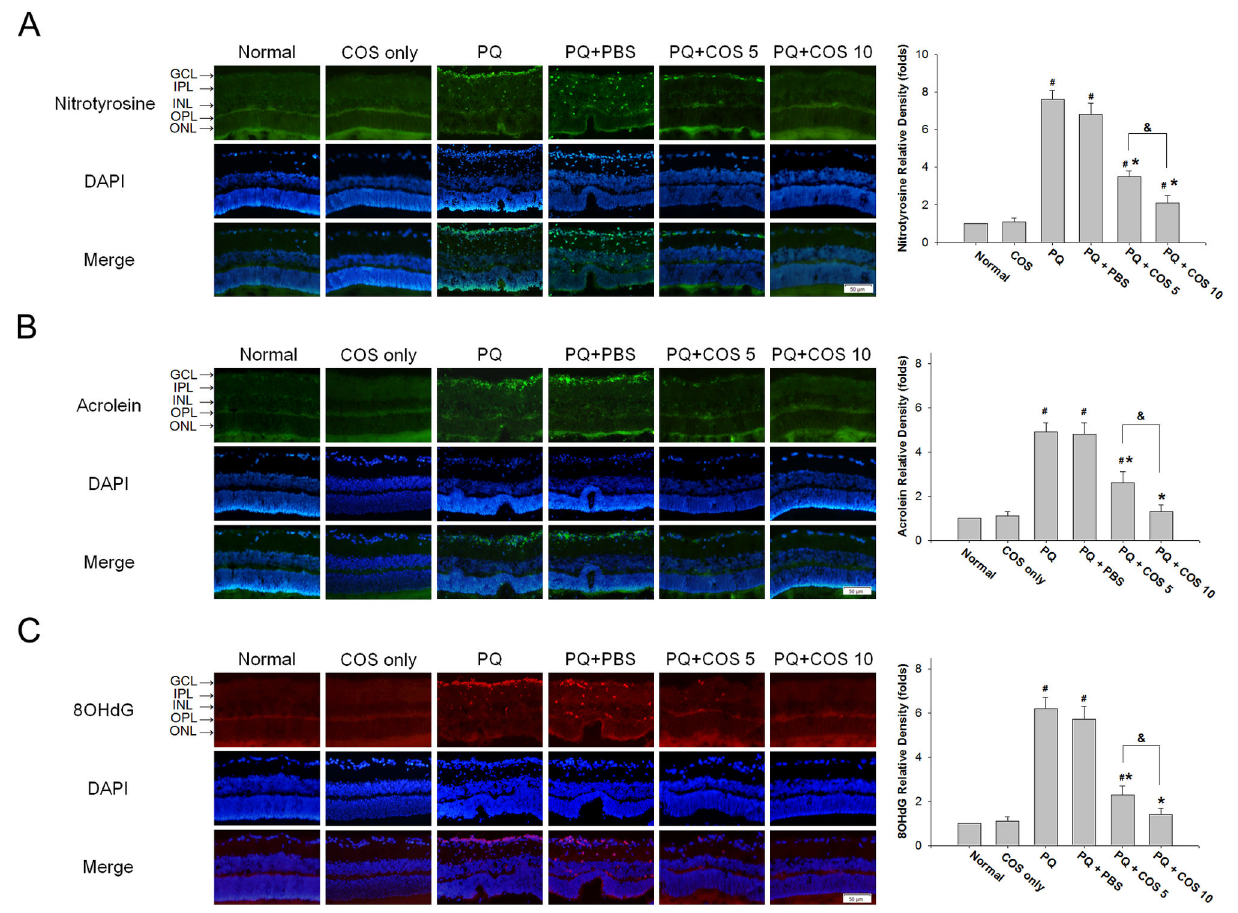
Figure 5. Effects of COS treatment on oxidative damages to retina. Retinal oxidative damages were evaluated by immunohistochemical staining of (A) nitrotysine (B) acrolein, and (C) 8-hydroxy-2'-deoxyguanosine (8-OHdG) at day 14. For quantitation of immunostaining, we first determined the immunostaining index, which could be measured and calculated from the following formula: Σ [(immunostaining density-threshold) × area (pixels)] / total cell number. The relative density of immunostaining was defined as immunostaining index of PQ only, COS only, PBS-treated, low-dose or high-dose COS treated groups / immunostaining index of normal group. Treatment with COS decreased the staining for nitrotysine acrolein and 8-OHdG in the retinas at day 14. (* P < 0.05 compared with PQ only or PBS-treated group; # P < 0.05 compared with normal; & P < 0.05 by ANOVA with post hoc Bonferroni test; N=3 in each